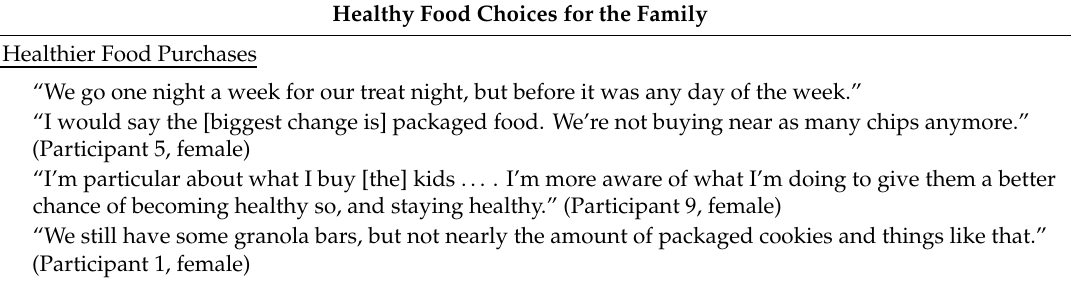
Table 3. Selected quotes related to parents’ perceptions of outcomes for parents and families. Healthy Food Choices for the